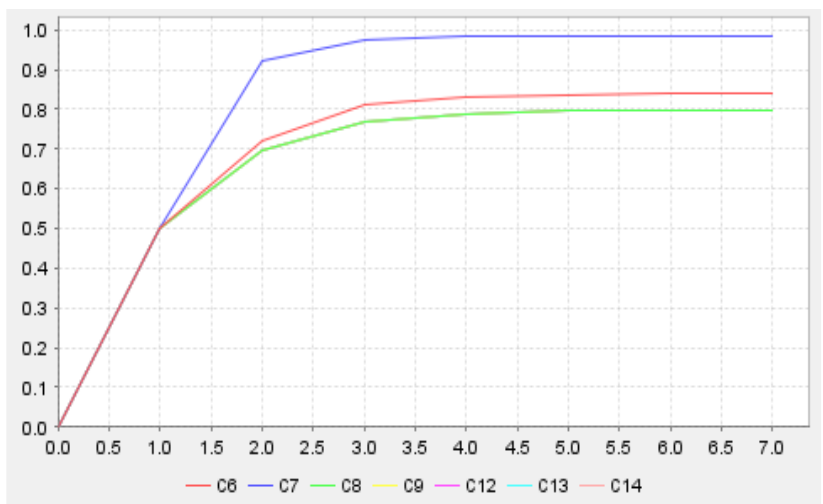
Fig. 12. FCM of S&E inference